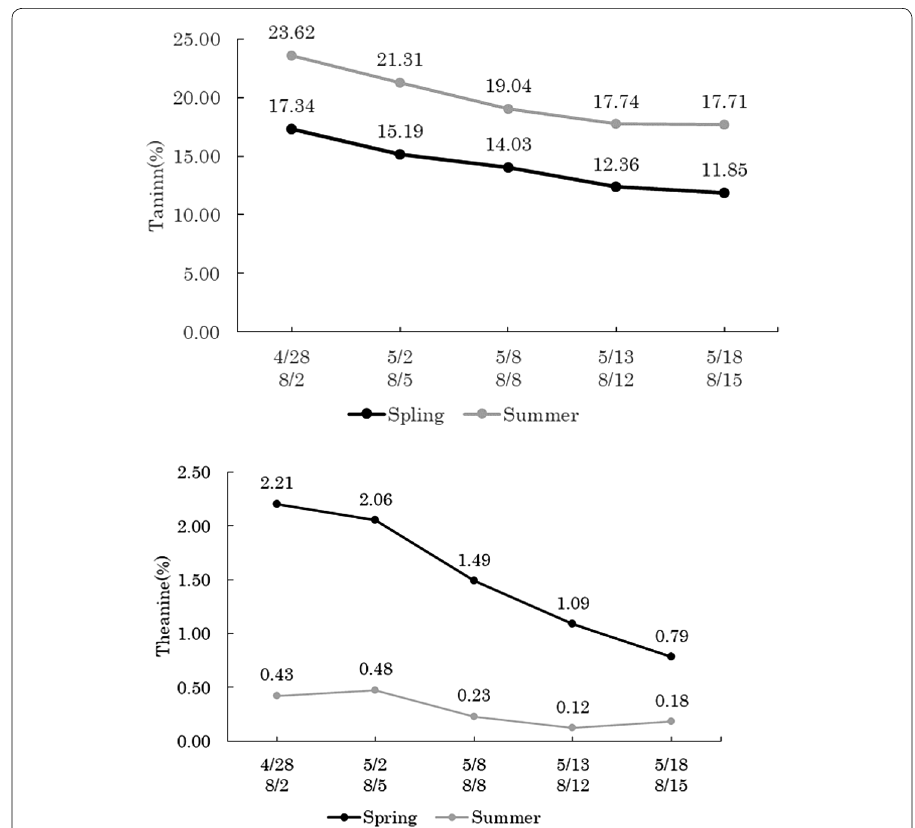
Fig. 5 Differences in the content of tannin and theanine by major harvest season (Anan and Nakagawa 1974)